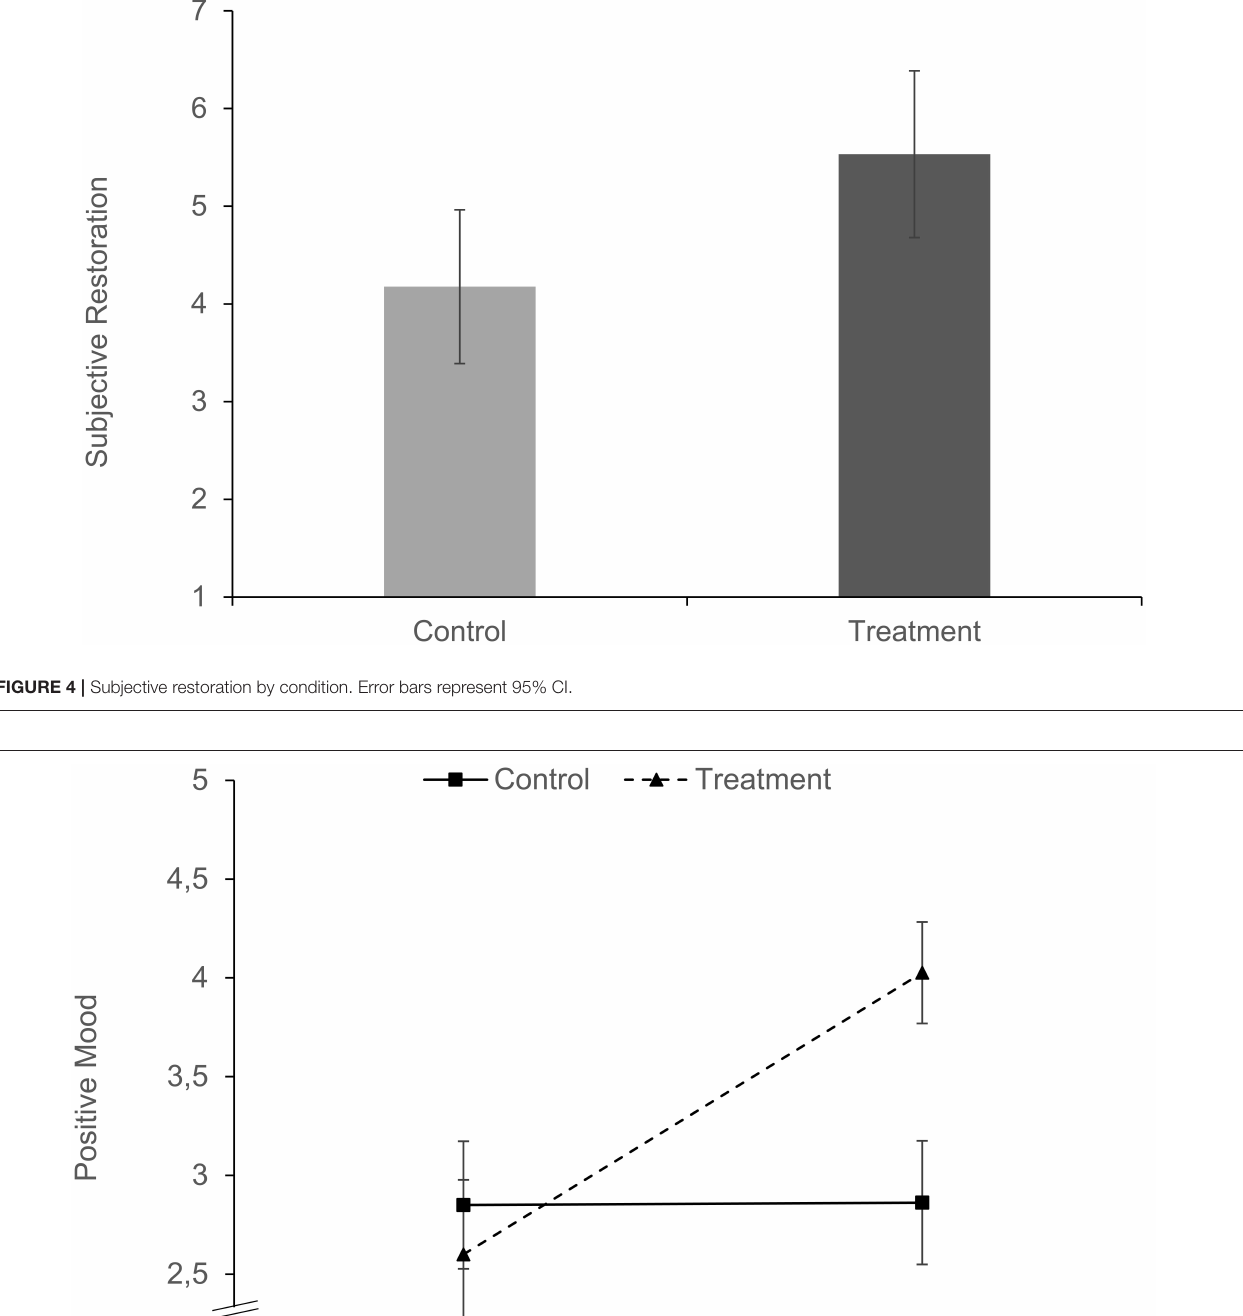
focus on the present moment. Capturing the user’s focus